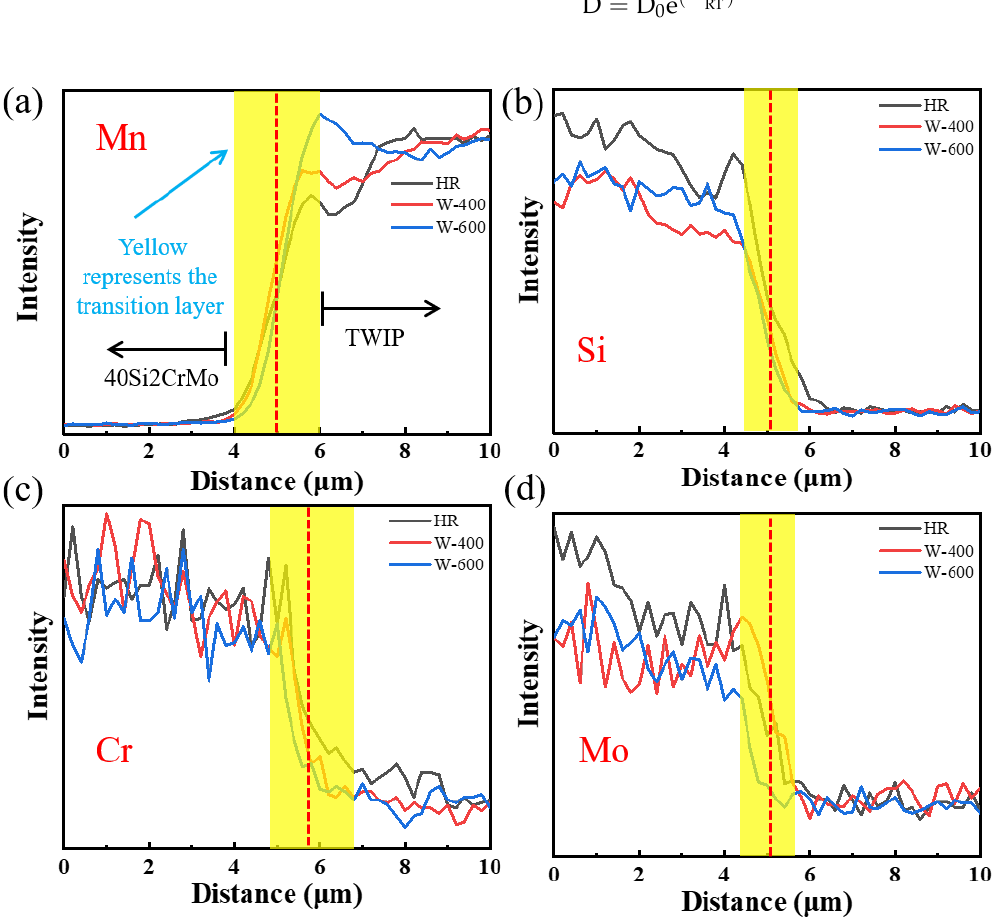
Figure 4. Elemental diffusion distances at the interface for different elements of the multilayer composite steel: ( a ) Mn element; ( b ) Si element; ( c ) Cr element; ( d ) Mo element. Table 2. Interfacial element diffusion distances of 18Mn/40Si2CrMo multilayer composite steel with different warm rolling temperatures.